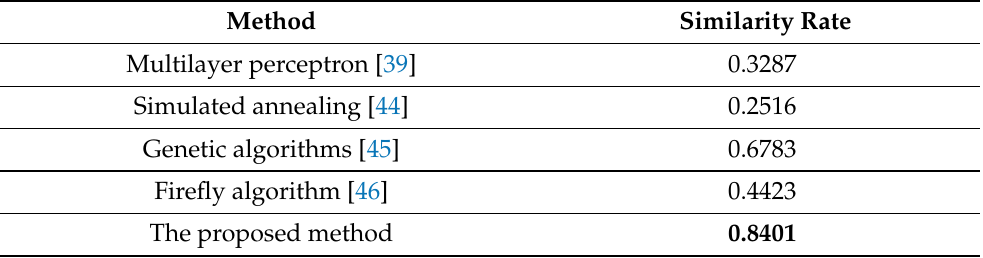
Table 2. Comparative results between our method and four alternative approaches in the literature (the best result is in